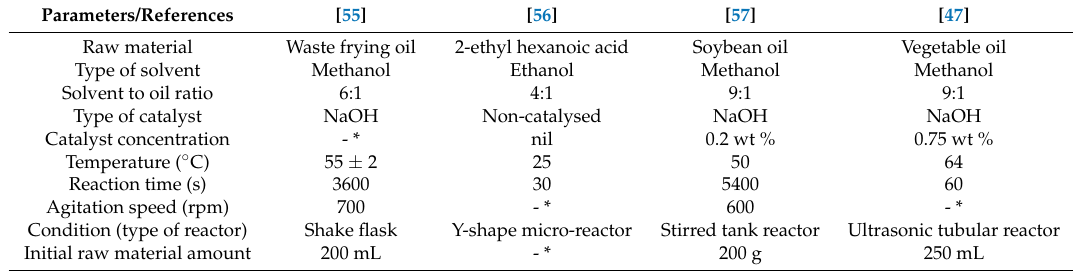
Table 6. Important parameters for transesterification/esterification process for producing